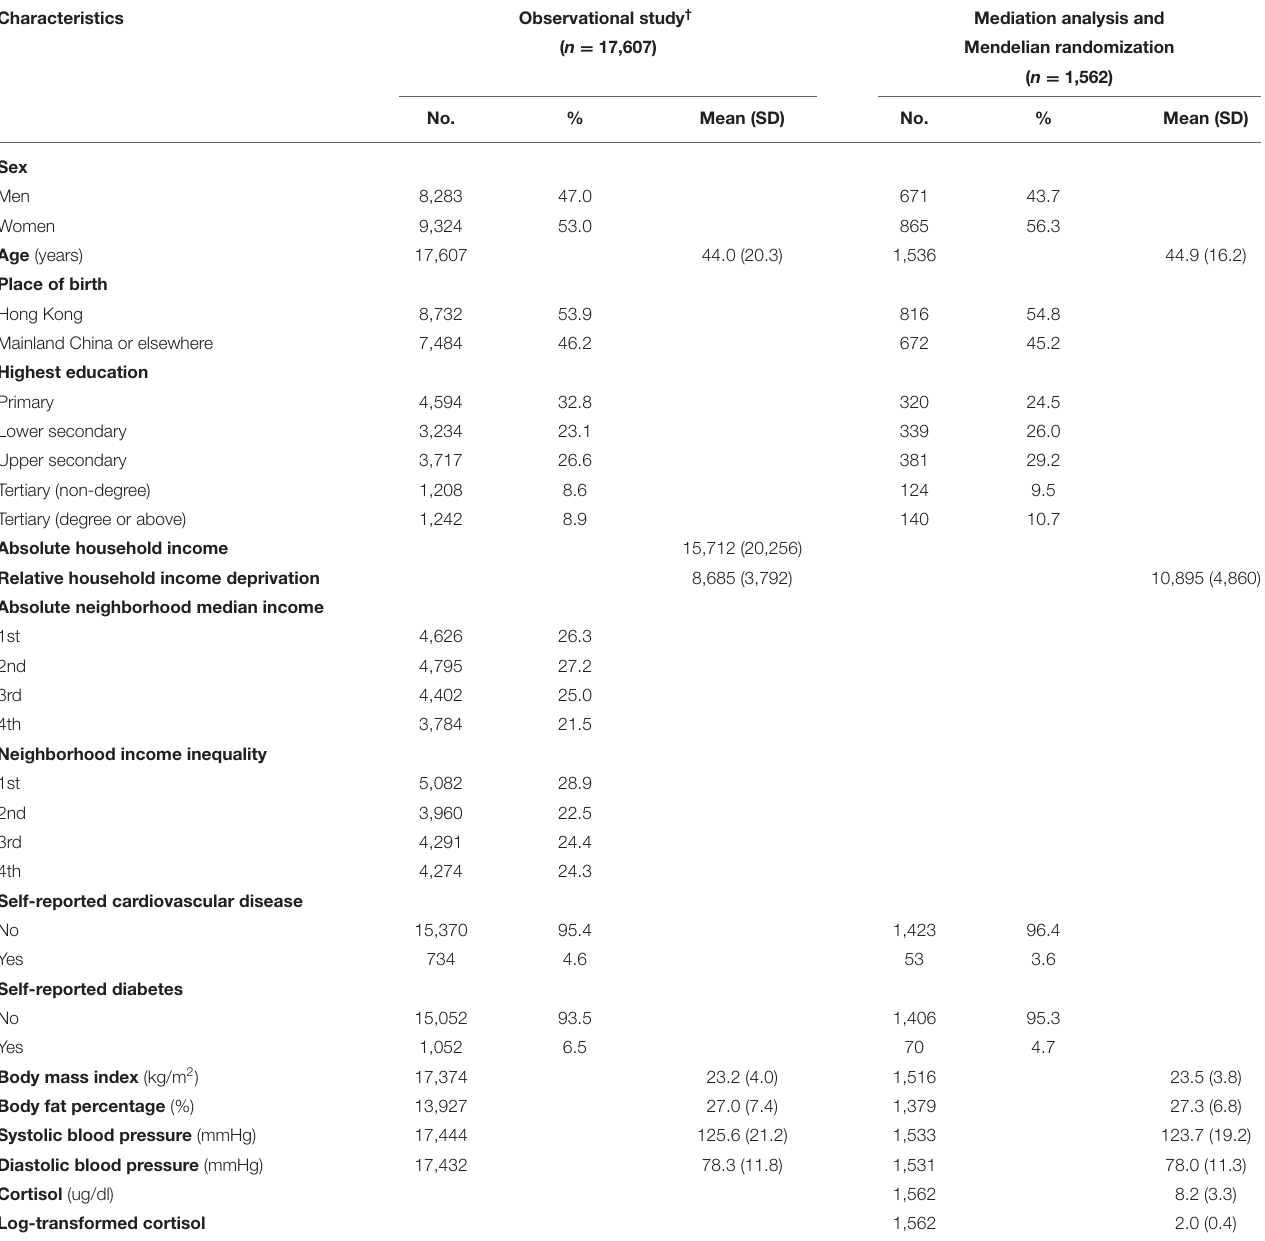
TABLE 1 | Baseline characteristics for 17,607 Hong Kong Chinese adults in the observational study of income and cardiovascular health and for 1,562 Chinese adults in the mediation analysis and Mendelian randomization study of cortisol and cardiovascular health from Hong Kong’s FAMILY Cohort.